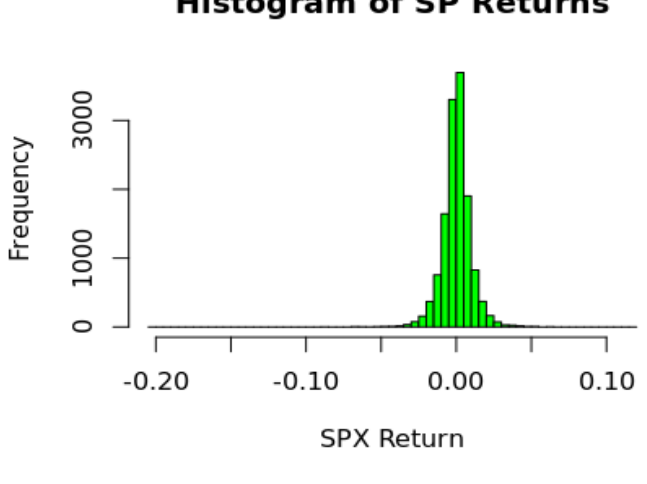
Figure 5. The distribution of daily S&P 500 index returns from 1963–2016. The mean return is 0.00031 and the standard deviation is 0.01. The skewness and kurtosis are − 0.62 and 20.68, respectively.